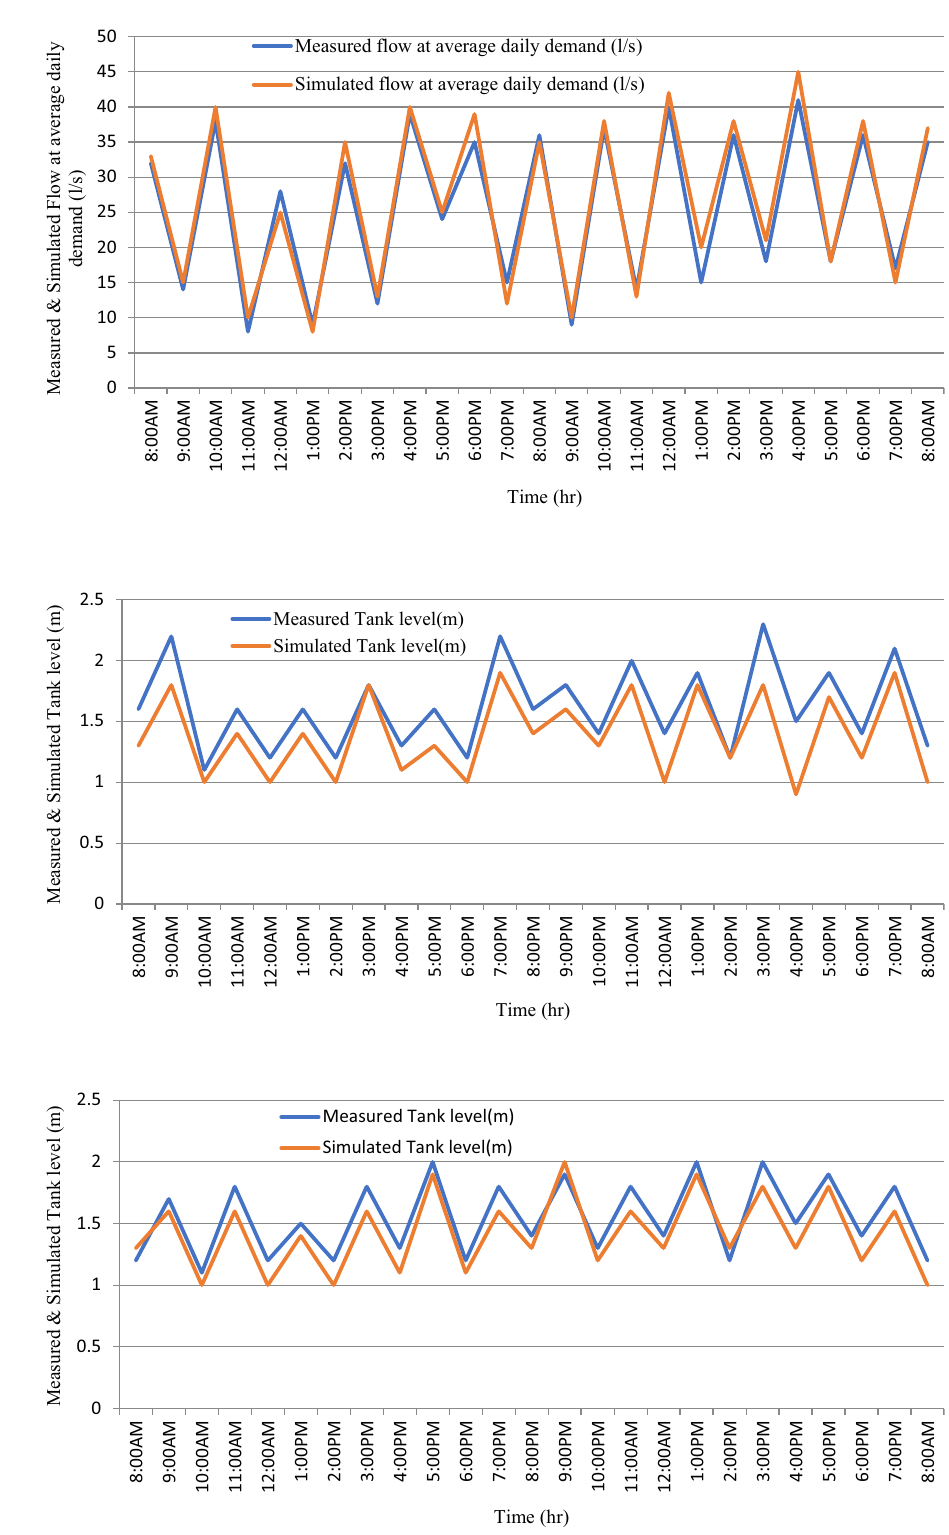
Different studies that were conducted in different towns show the different values of the model in both calibra-